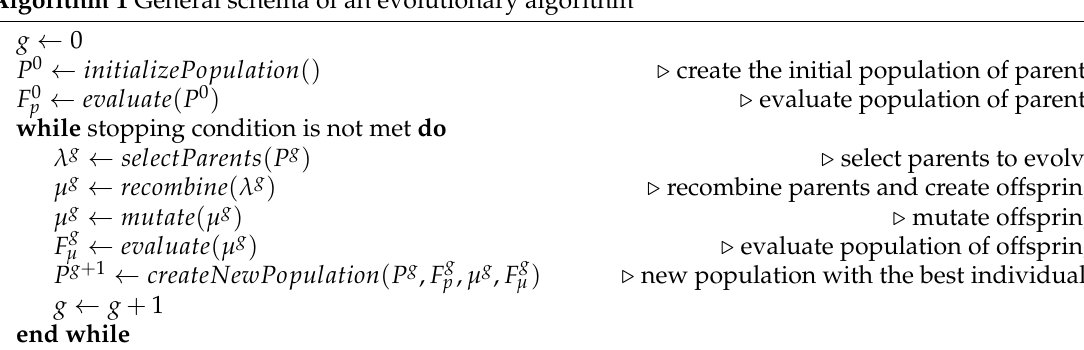
Algorithm 1 General schema of an evolutionary algorithm